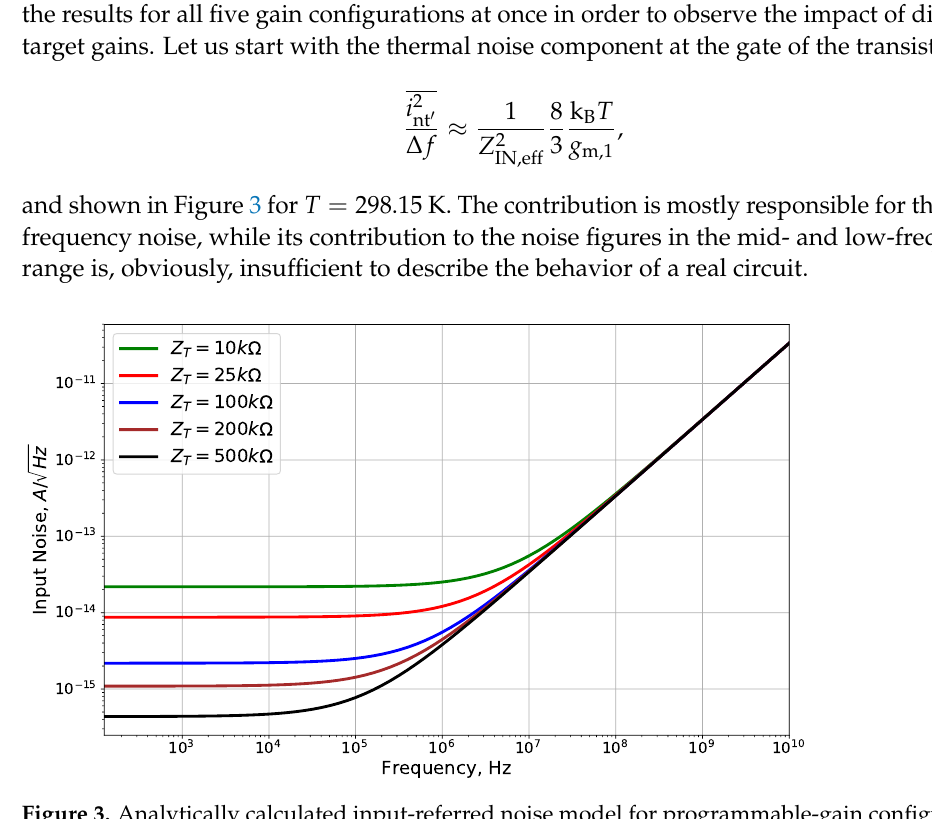
Figure 3. Analytically calculated input-referred noise model for programmable-gain configuration with M 1 thermal noise component only (example case for TSMC 0.18 µ m